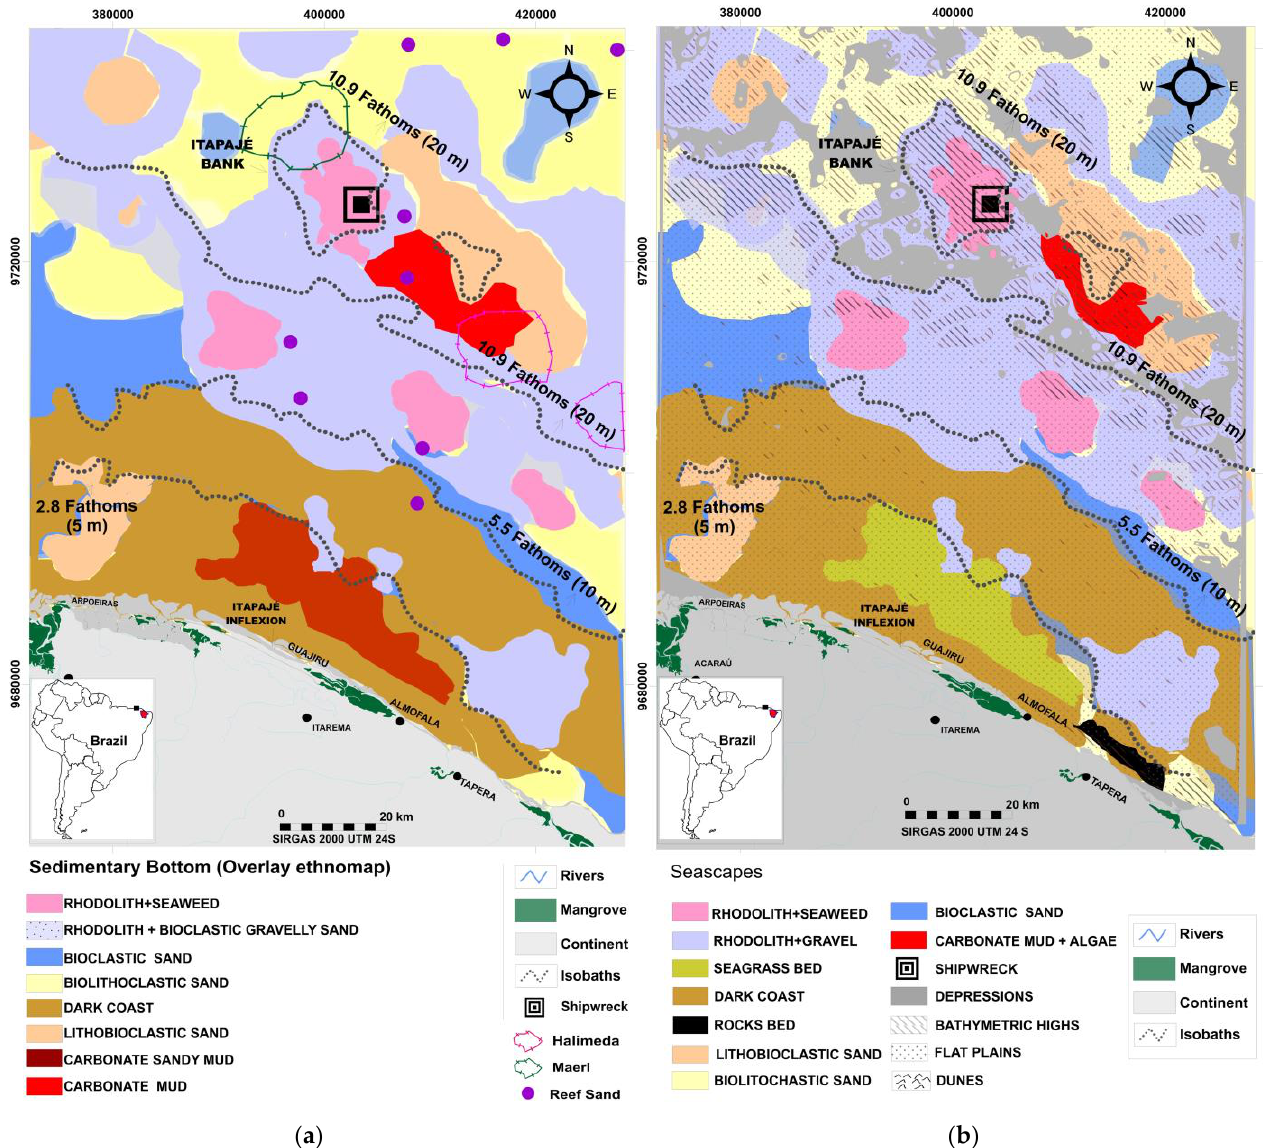
Figure 6. ( a ) Integration of sedimentary facies (Figure 5b) with participatory mapping (Figure 3a,b). ( b ) Seascape map for the fisheries.